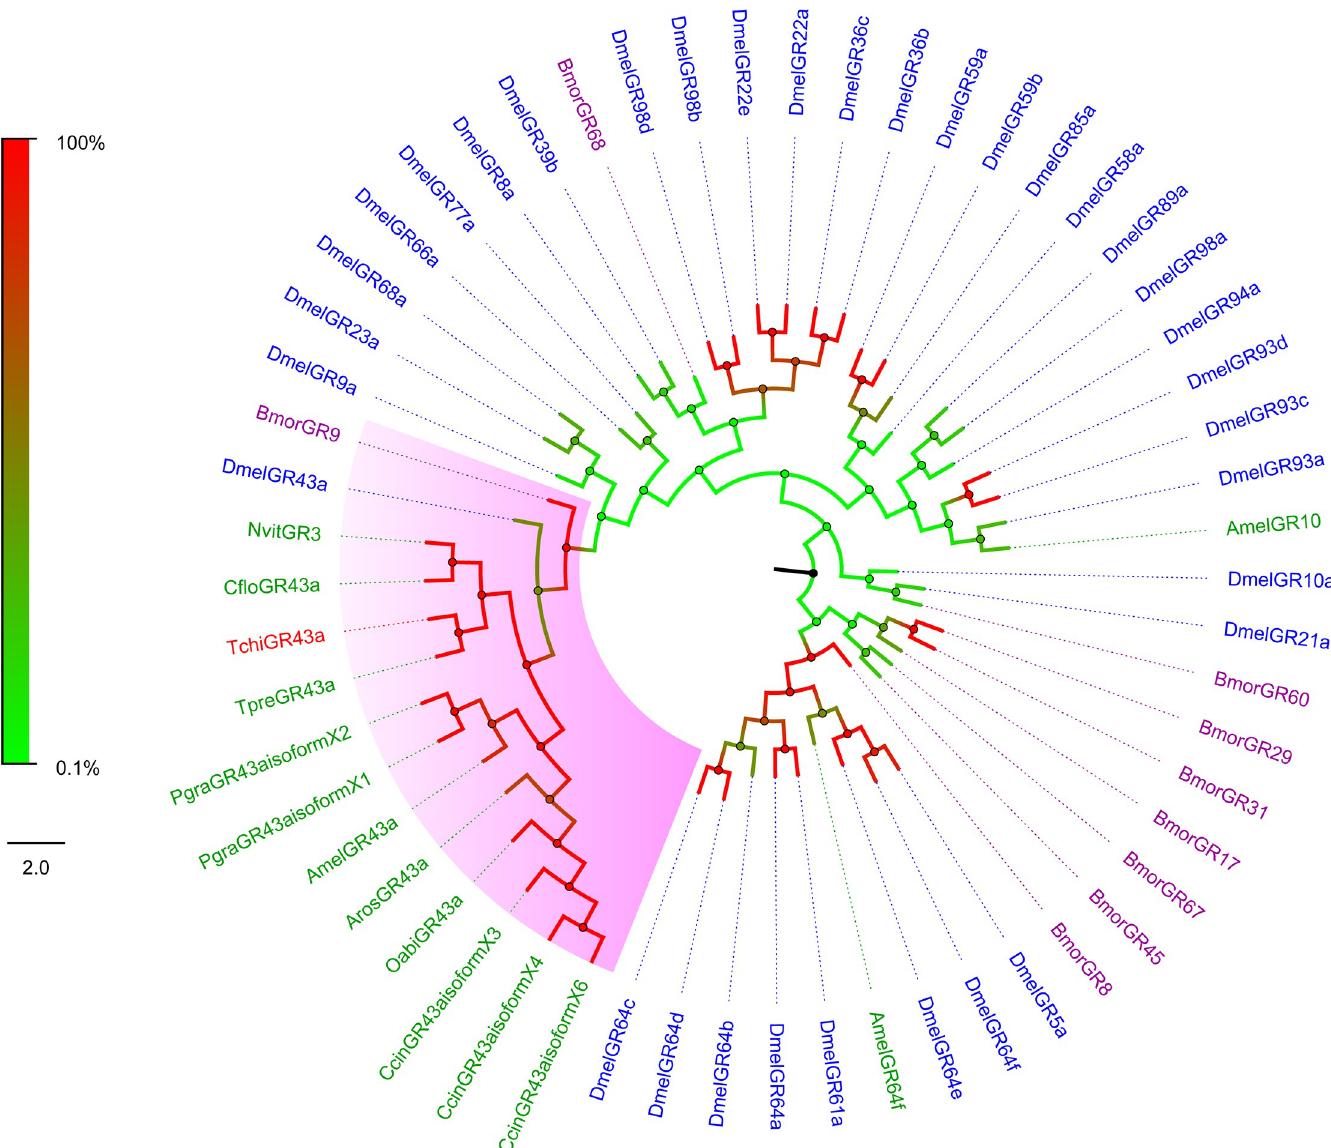
Fig 3. Phylogenetic analysis of putative gustatory receptors of T . chilonis . The tree was constructed in MEGA6.0 using the neighbor-joining method. TchiGR43a from T . chilonis are labelled with red, GRs from D . melanogaster (Diptera) are labelled with blue, GRs from B . mori (Lepidoptera) are labelled with purple, and GRs from other Hymenoptera insects ( T . pretiosum , N . vitripennis , Apis mellifera , C . floridanum , Cephus cinctus , Orussus abietinus , Pseudomyrmex gracilis and Athalia rosae ) are labelled with green.